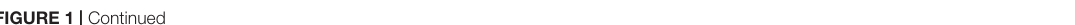
FIGURE 1 | Continued following micro-injection of mCherry-SH1000 biofilm bacteria. Images correspond to the maximal projection intensities of the EGFP signal, and the yellow line indicates the ROI where the “Sum of EGFP fluorescence intensities” was measured. Scale bar: 2 mm. One representative image is shown from at least 3 independent experiments. (G) Ratio of the sum of EGFP fluorescence intensities to ROI areas (median ± IQR, number of ear pinnae tissues: N C = 4, N P = 5–8, N BF = 4–9, from at least 3 different experiments, Mann-Whitney two-tailed test, ∗ p <